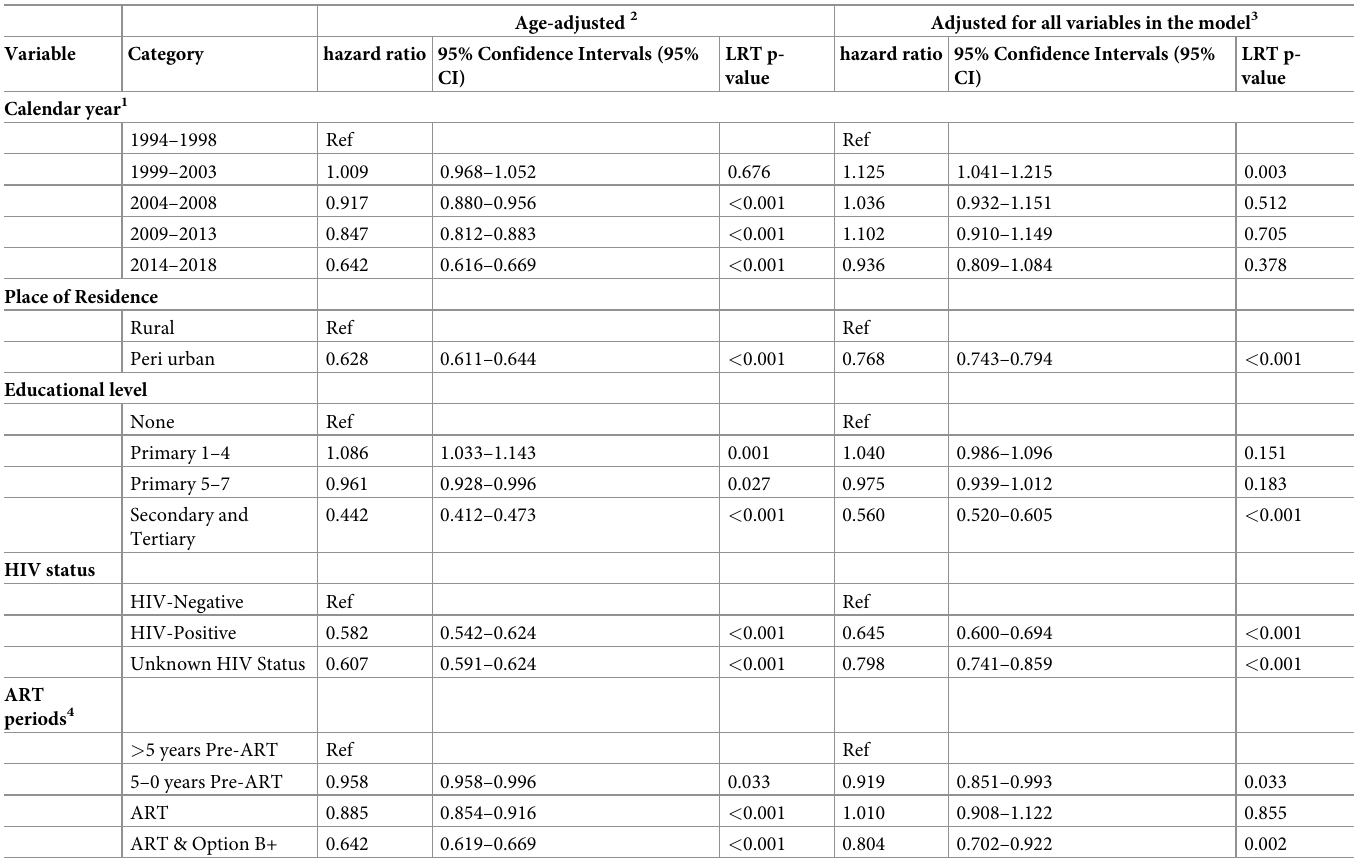
Table 3. Independent factors associated with fertility changes among women aged 15–49 years (1994–2018): Multivariable